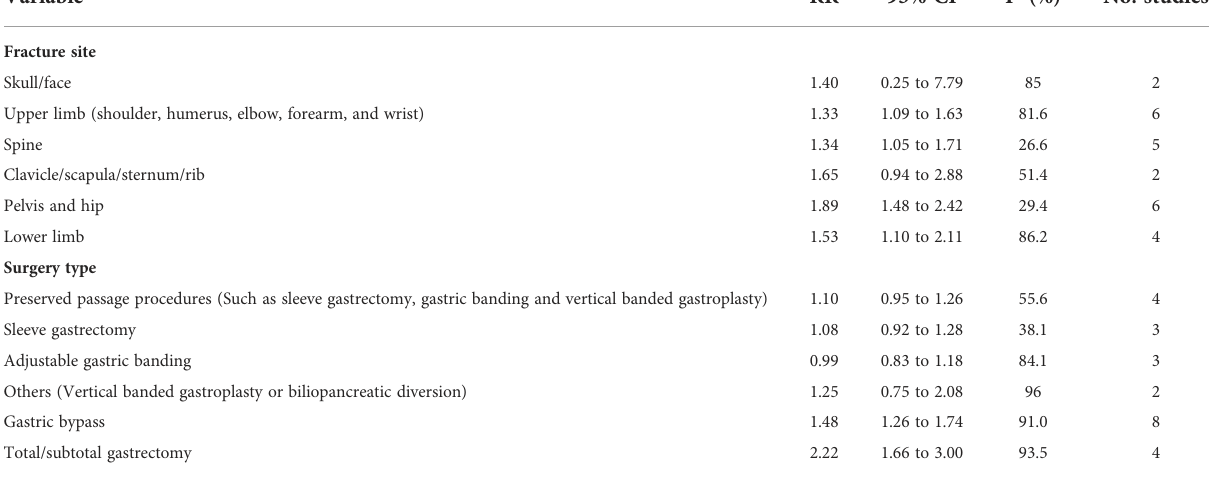
TABLE 4 Subgroup analyses based on fracture site and surgery type.